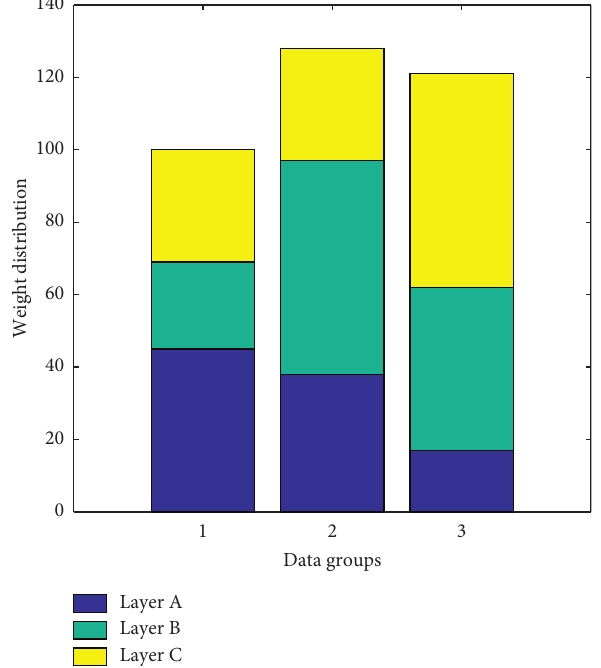
Figure 4: The histogram of the weight distribution of the number of image recognition